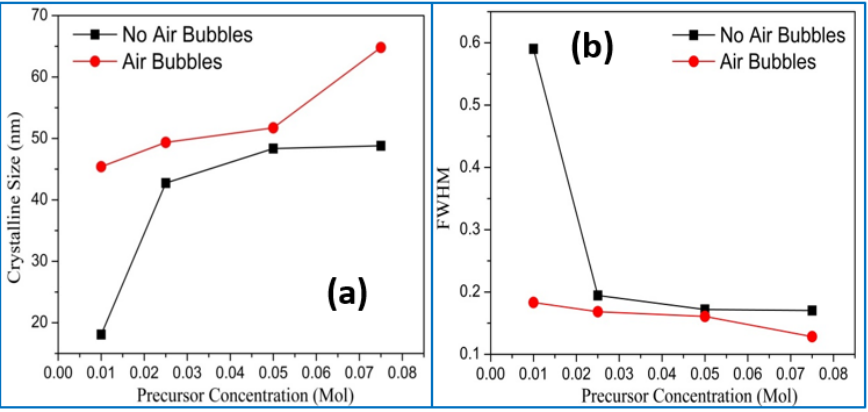
Figure 8. ( a ) Variation of crystalline size and ( b ) full-width at half-maximum FWHM along diffraction peak (002) at precursor concentrations of ZnO nanorods grown in in the presence and absence of air bubbles.